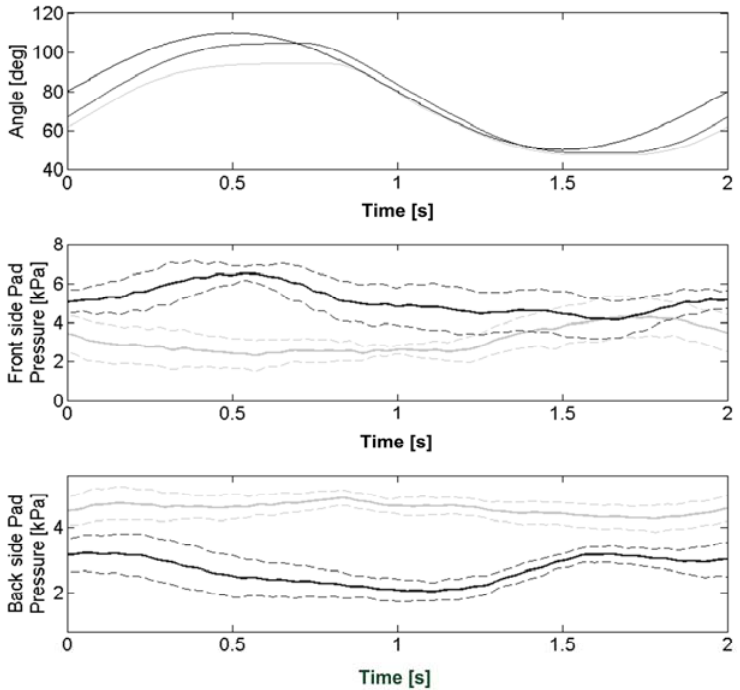
Figure 11. NEUROExos joint trajectory, front- and back-side PSP1.0 pressure profiles during a prototypical rehabilitation task, with and without the user reaction . Top panel reports: the reference trajectory of the rehabilitation task (dashed line), the “no action” trajectory (gray line), and the “pre-defined action” performed by the subject (black line). Middle and bottom panels report respectively front- and back-side PSP1.0 pressure profiles: the “no action” condition is the gray line, the “pre-defined action” is the black line. Pressure profiles are averaged over ten sinusoidal motions and reported along with standard-deviation contour (dotted line). We assume that the elbow is fully extended when the joint angle is equal to zero (figure adapted from [33], ©2011, with permission from